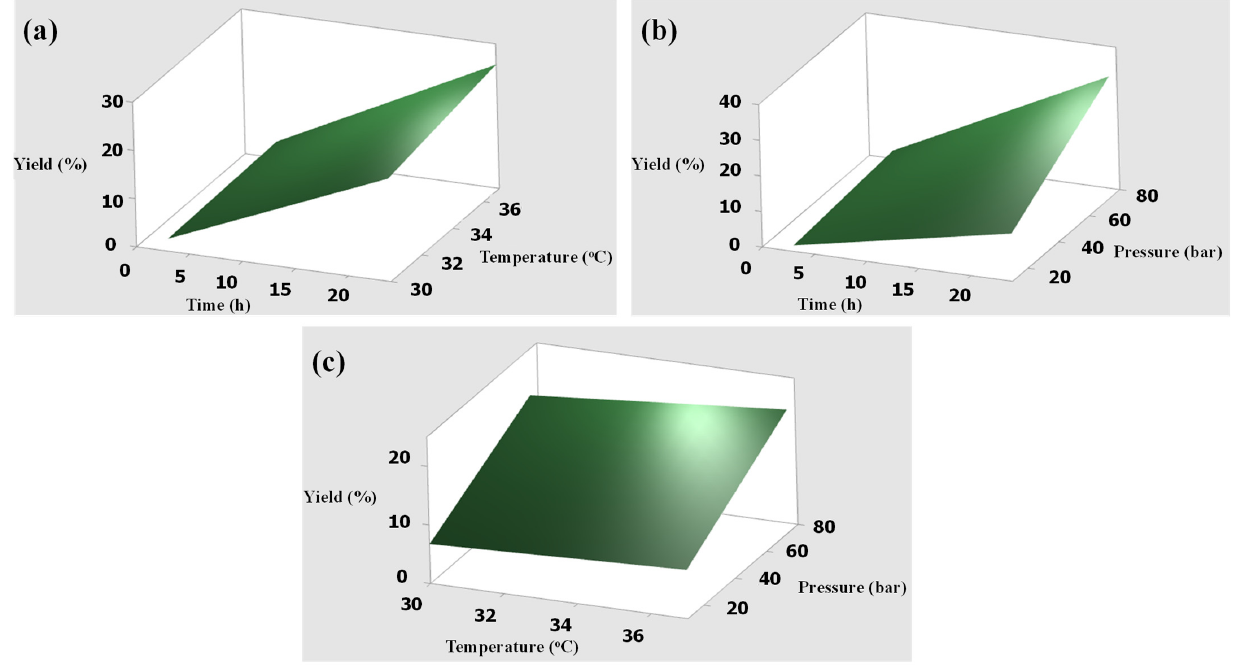
Figure 1. Surface plots of the interaction effects on yield obtained from the skin: ( a ) time and tem- perature, ( b ) time and pressure, ( c ) temperature and pressure.